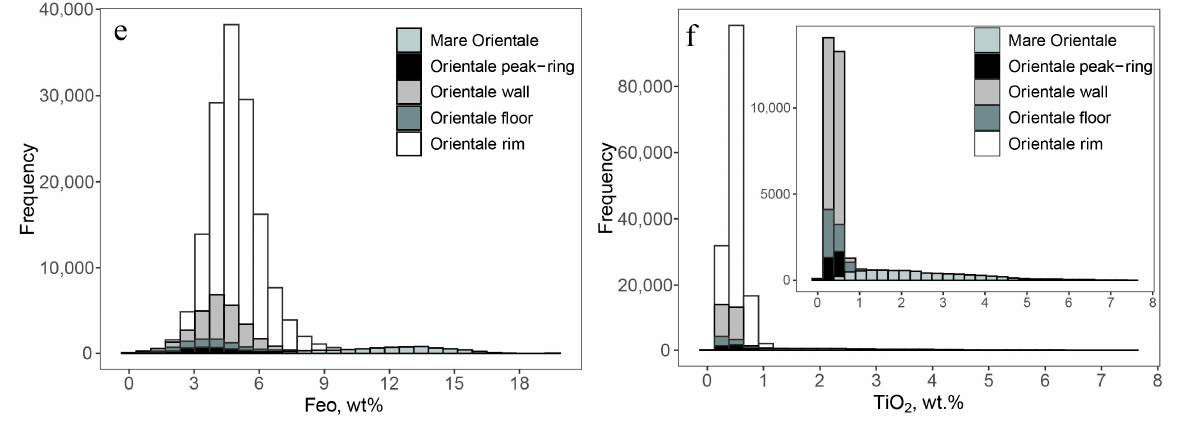
Figure 11. The frequency distribution of FeO and TiO 2 contents in the landforms of Dirichlet–Jackson Basin ( a , b ), Nectaris Basin ( c , d ) and Orientale Basin ( e , f ). The lunar regolith is dominated by phases such as plagioclase, pyroxene, olivine, ilmenite, and impact-generated glasses. Pyroxene spectra exhibit two major absorption bands near 1000 nm and 2000 nm both due to Fe 2+ crystal field transitions. Reflectance spectra of olivine exhibited a major absorption peak near 1000 nm. In our paper, the M3 data were used to superimpose a certain range near the main mineral absorption peaks based on the IBD method, and IBD maps for the three basins were derived (Figure 12).